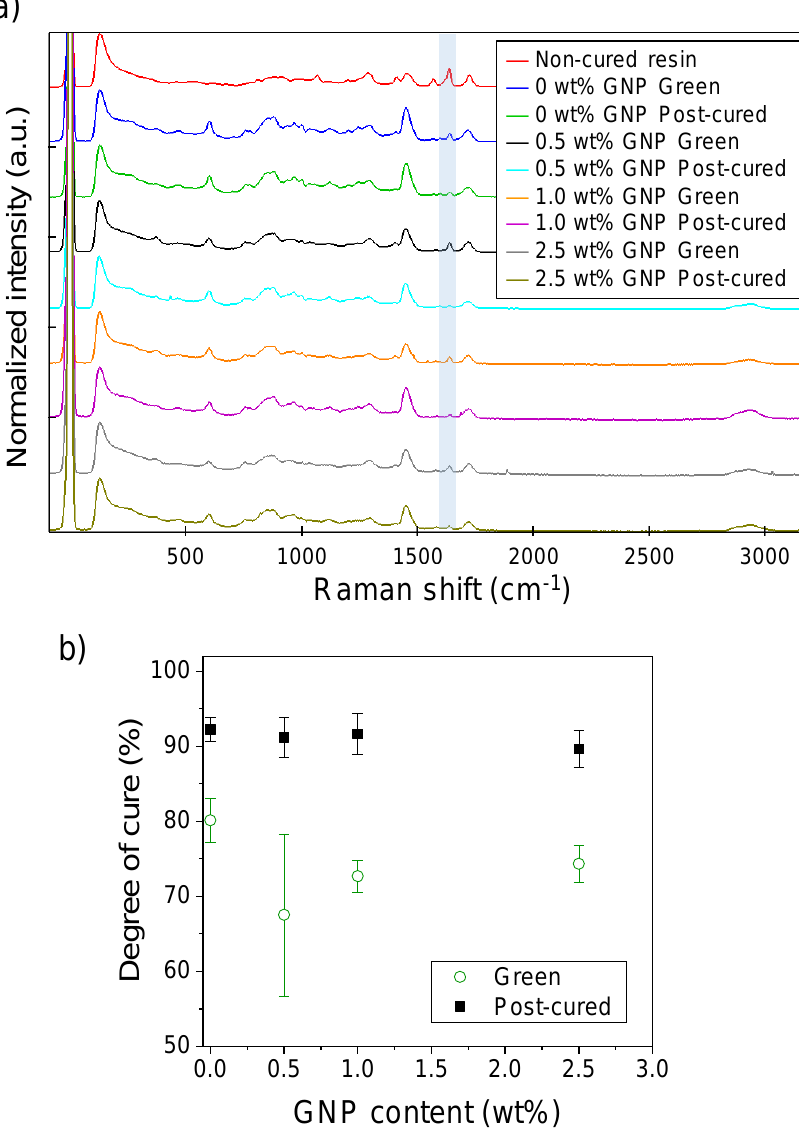
Figure 4. ( a ) Characteristic Raman scattering spectra of non-cured, green and post-cured resins containing 0–2.5 wt % GNP. Peaks at 1636 cm −1 corresponding to the CH 2 =CH–R stretching of the acrylate groups are highlighted in blue; ( b ) amount of resin cured obtained from the Raman spectroscopy results as a function of the GNP content for the green and post-cured samples.